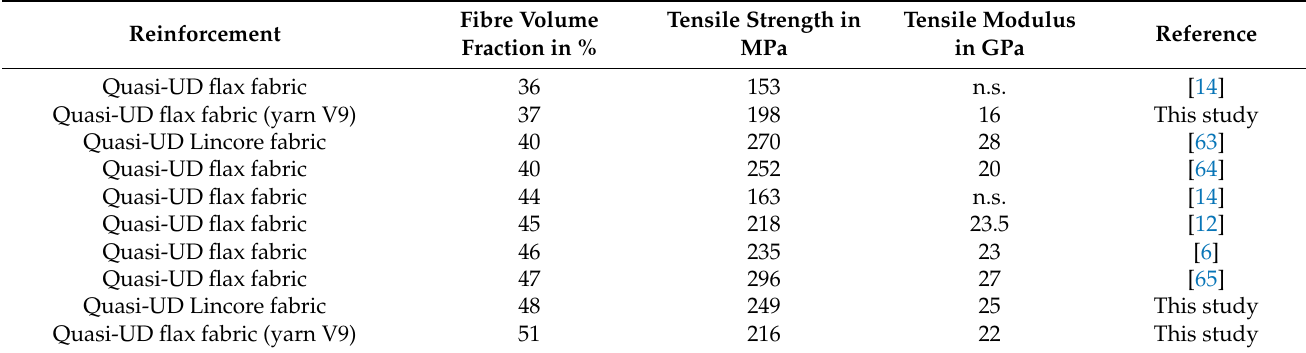
Table 6. Comparison of manufactured composites’ tensile properties with other high-performance flax fibre-reinforced epoxy resins described in the